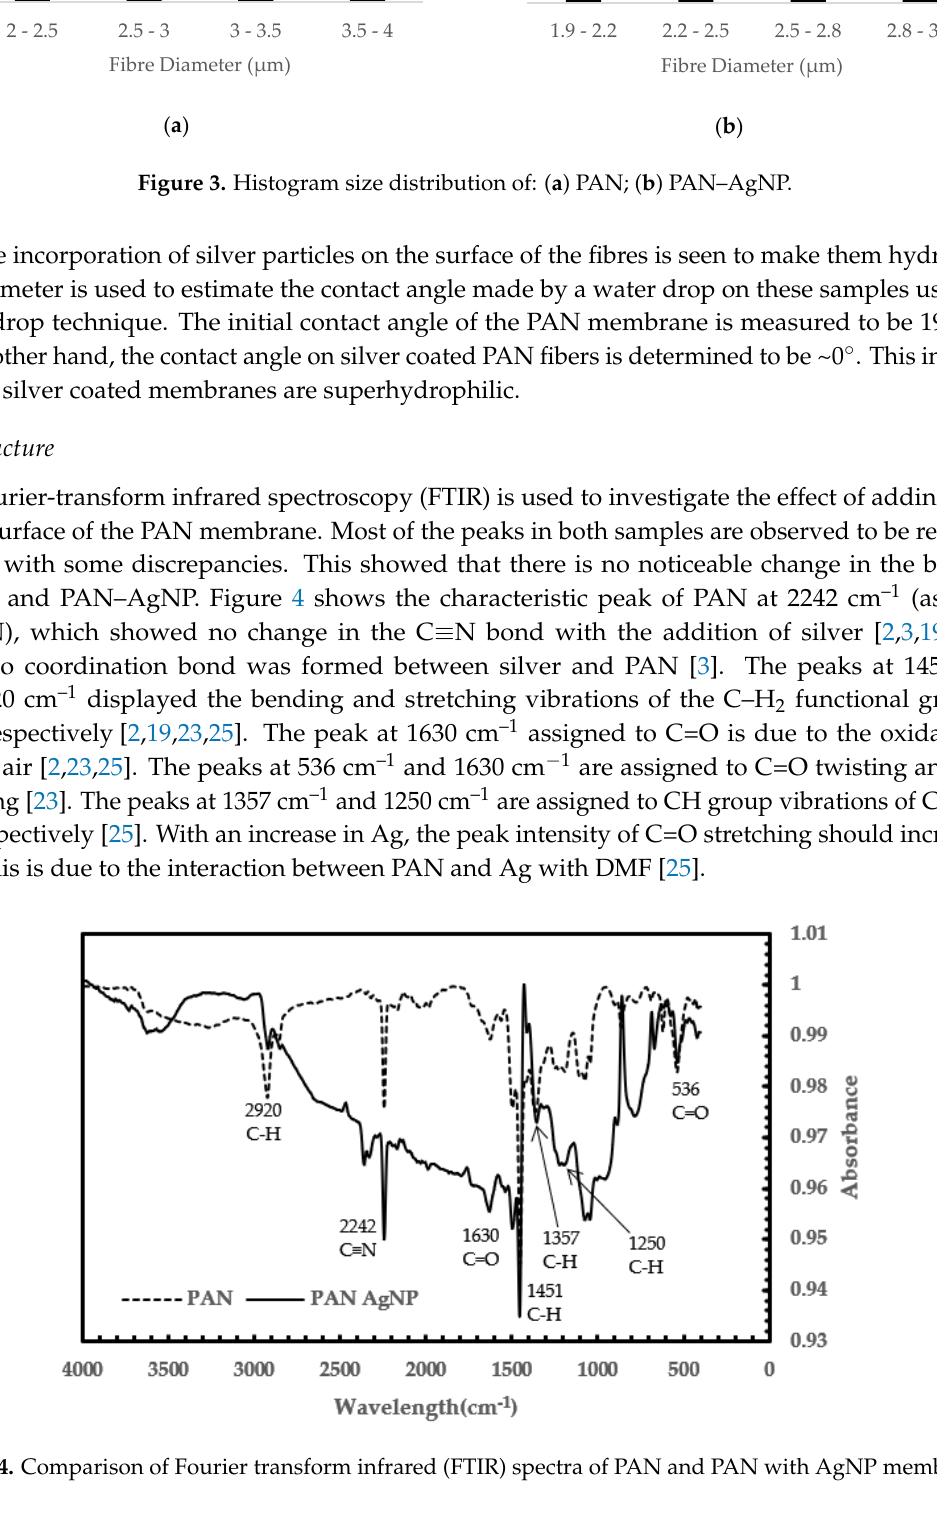
Figure 2. Scanning electron micrographs (SEM) of electrospun PAN fibres: ( a ) PAN at ×200